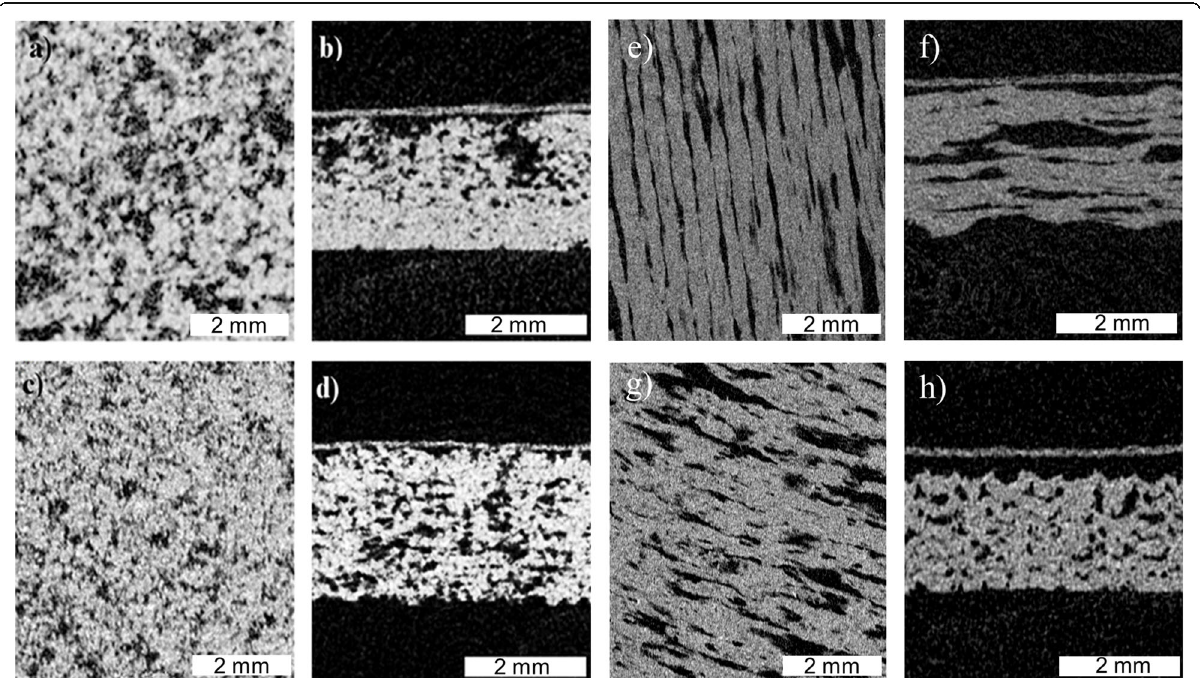
Fig. 7 Cross-sectional μ -CT images of 3D-printed XRD samples displaying the fibre dispersion within AC25% ( a , b ),AC50% ( c , d ), MCC10% ( e , f ) and MCC20% ( g , h ) as sections through the X-Y plane ( a , c , e , g ) and Y-Z plane ( b , d , f , h